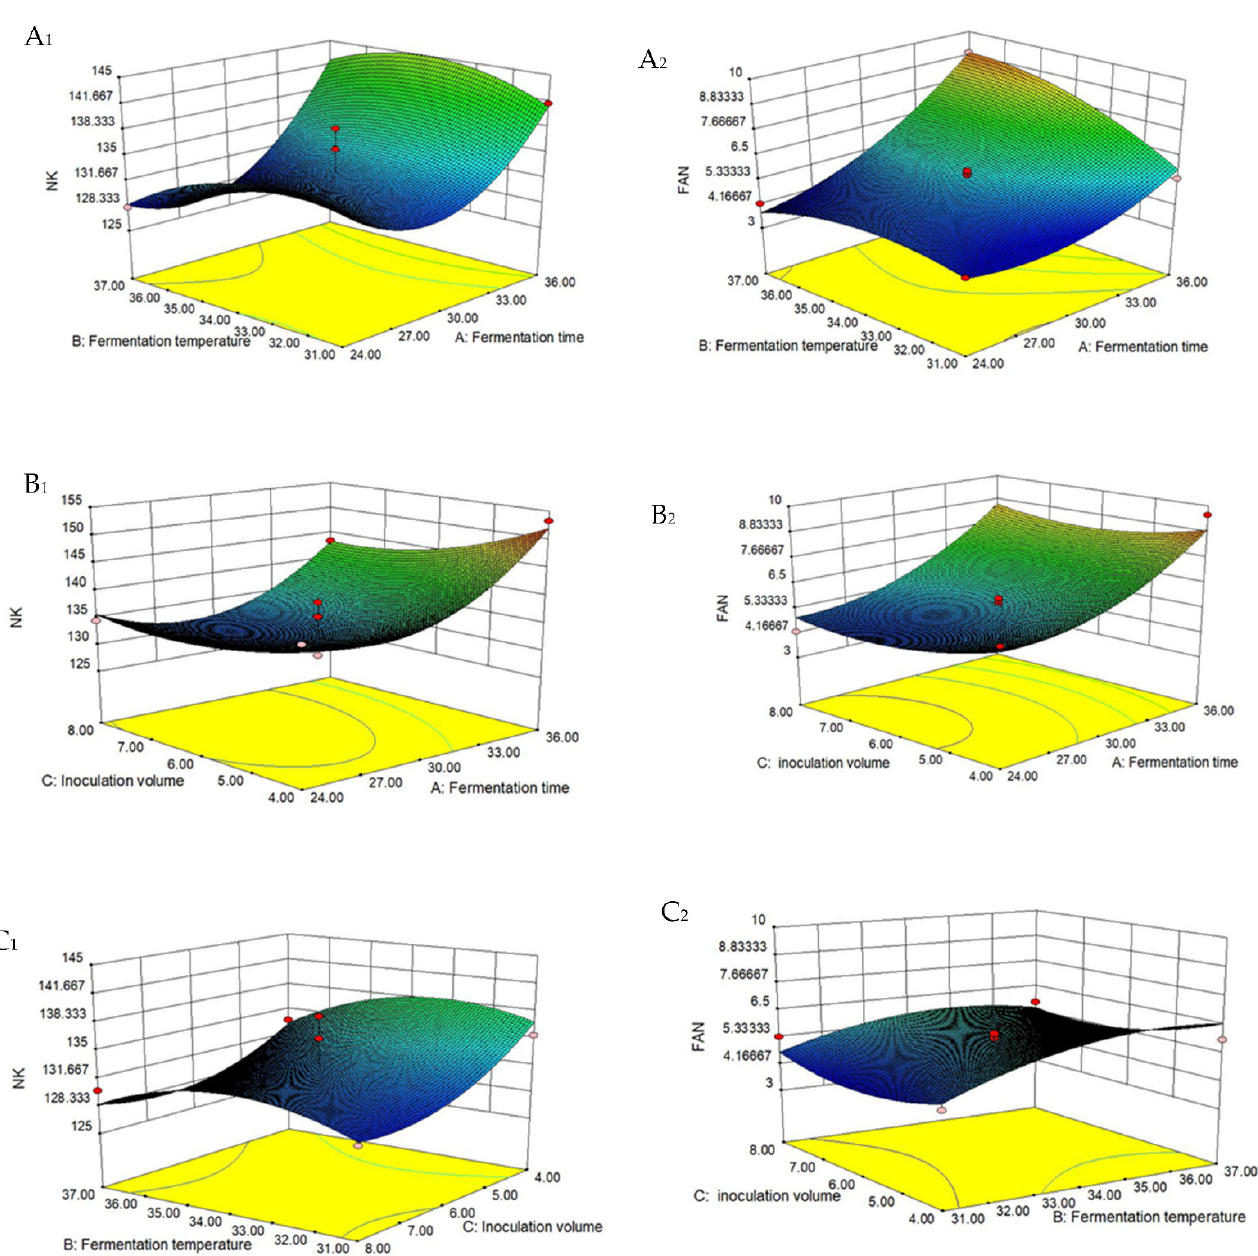
Figure 5. Response surface diagram of NK activity and FAN content as a response to the interaction of: ( A 1 , A 2 ) fermenta- tion temperature and fermentation time (inoculation amount = 6%), ( B 1 , B 2 ) inoculation amount and fermentation time (temperature = 34 °C), ( C 1 , C 2 ) inoculation amount and fermentation temperature (time = 30 h).